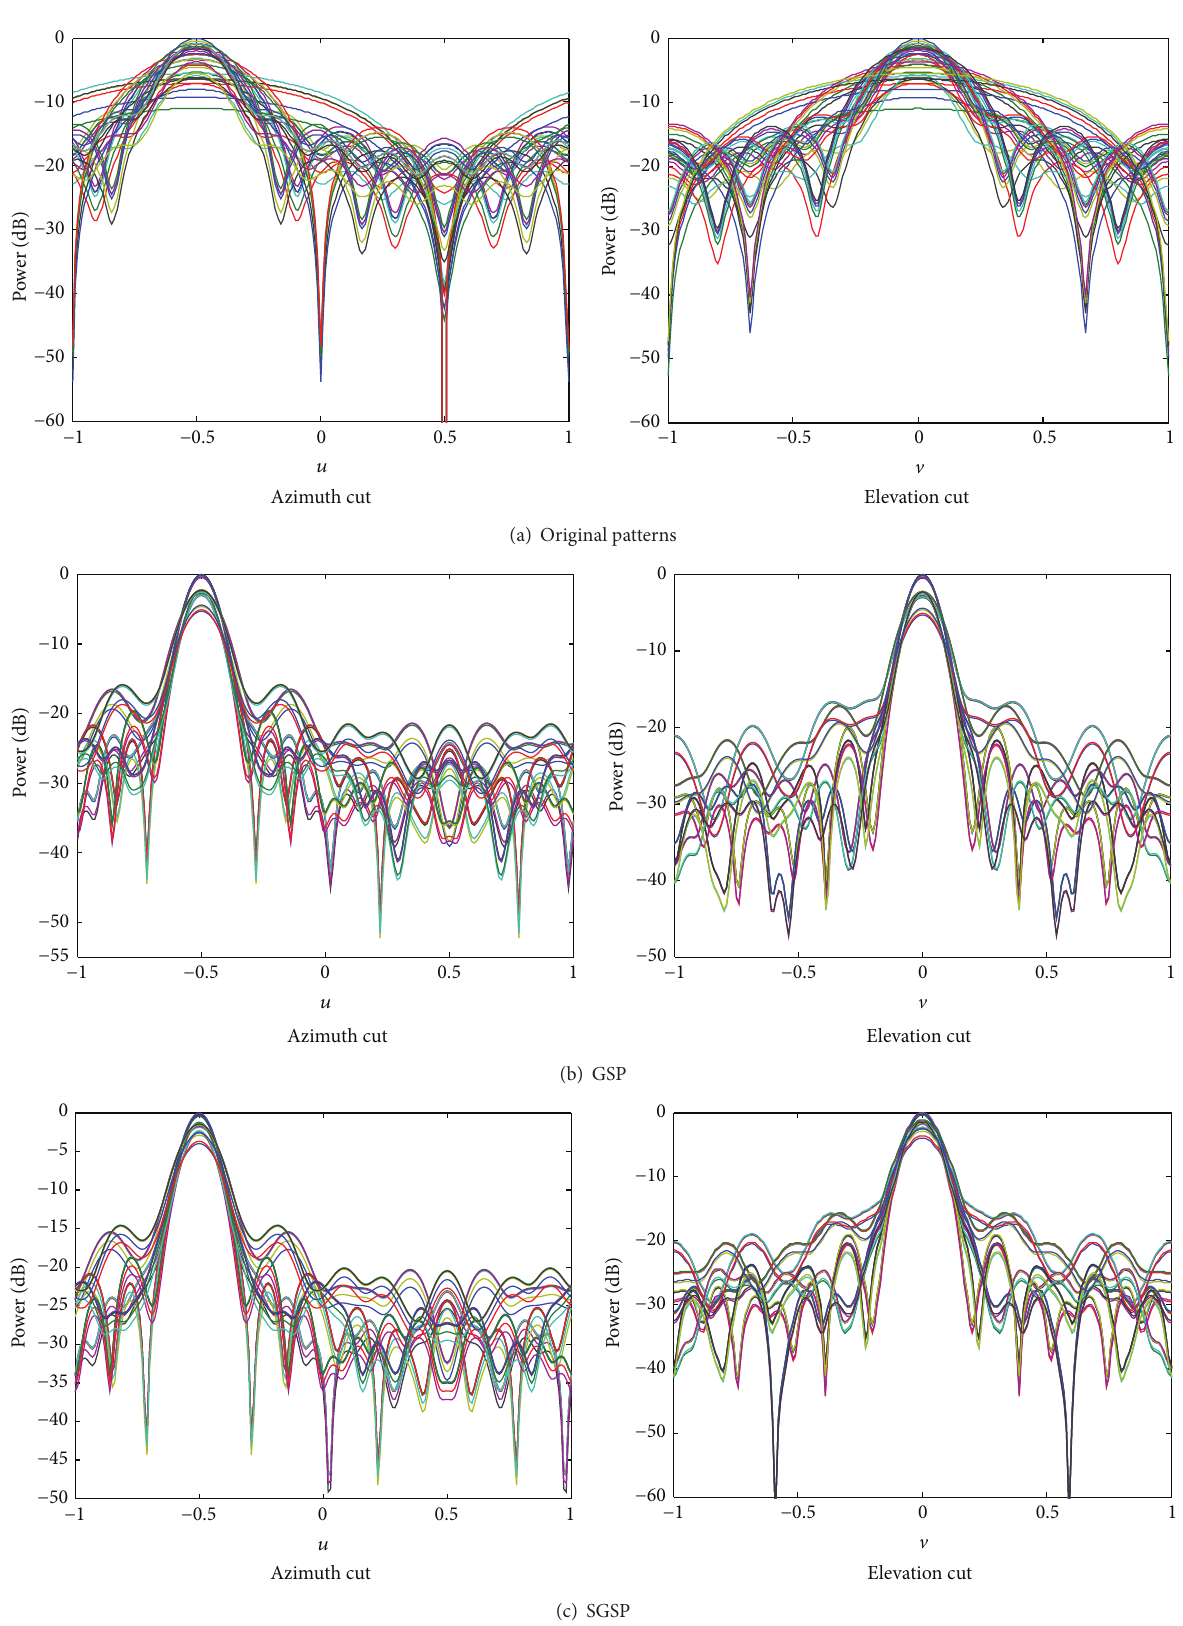
Figure 3: Subarray patterns obtained by several